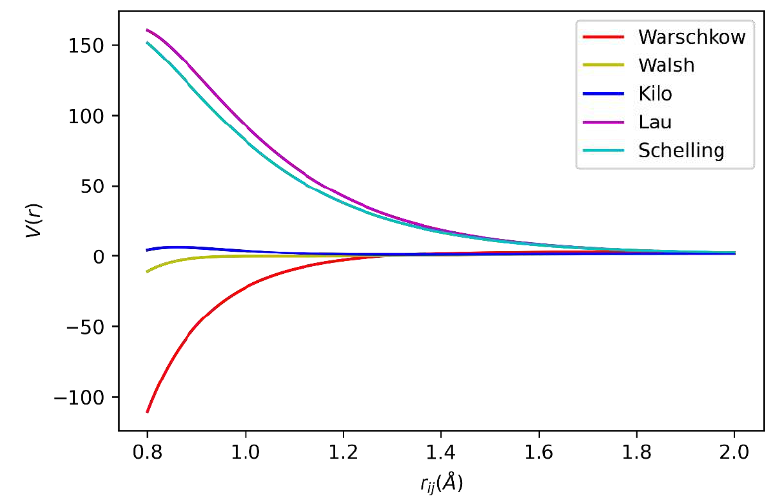
Figure 4. Oxygen-oxygen ion potential by analyzed models.